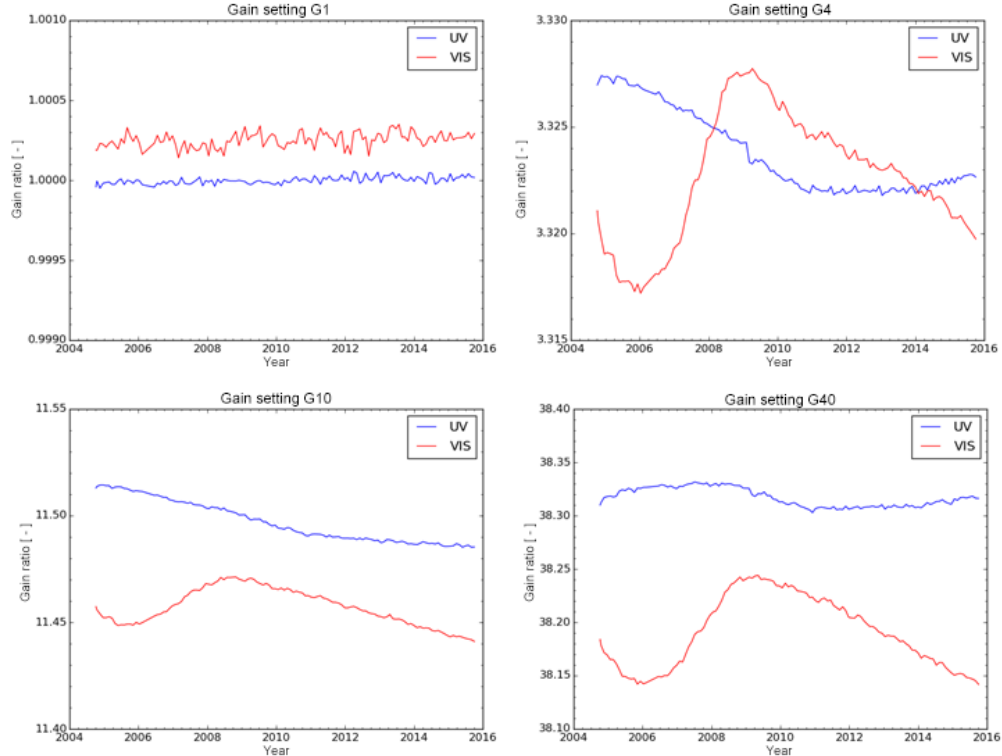
Figure 8. Gain ratio trends over the mission time for the four gain settings. The very small deviation from 1 for gain setting G1 in the VIS channel (upper left panel) is an indication of the accuracy of the analysis method.